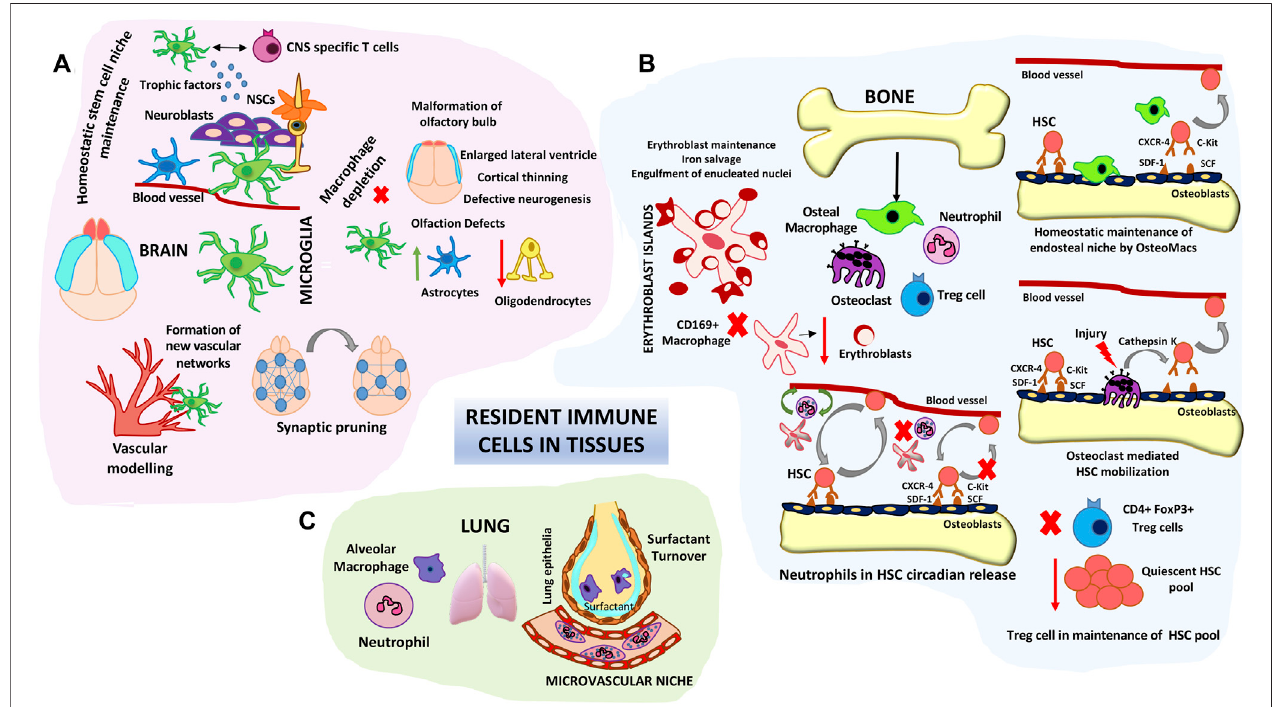
FIGURE3| Rolesofresidentimmunecellsintissuehomeostasisandstemcellmaintenance/differentiation. (A) Microglialcellfunctionsinbraintissuehomeostasis. Schematic represents the roles of microglia in fi ne tuning neuronal synapses, maintaining the neural stem niche and facilitating vascular modelling. Microglial depletion studies have shown structural defects in different areas of the brain such as the olfactory bulbs, cortex and lateral ventricles. (B) Resident Immune components in HSC niche homeostasis. Bone macrophages (Osteomacs) as well as osteoclasts modulate endosteal niches and in fl uence HSC retention and egress into circulation. Central CD169 + macrophages form specialized erythroblast support niches in the bone marrow. Intimate cross-talk between neutrophils and stromal macrophages control the steady state circadian traf fi cking of HSCs. Immune-regulatory FoxP3 + T reg cells prevent exhaustion of endosteal HSC. (C) Alveolar macrophages and neutrophils comprise key lung niche components. Vessel associated neutrophils are key barriers to pathogenic invaders and environmental alarms. Alveolar macrophages are involved in lung surfactant